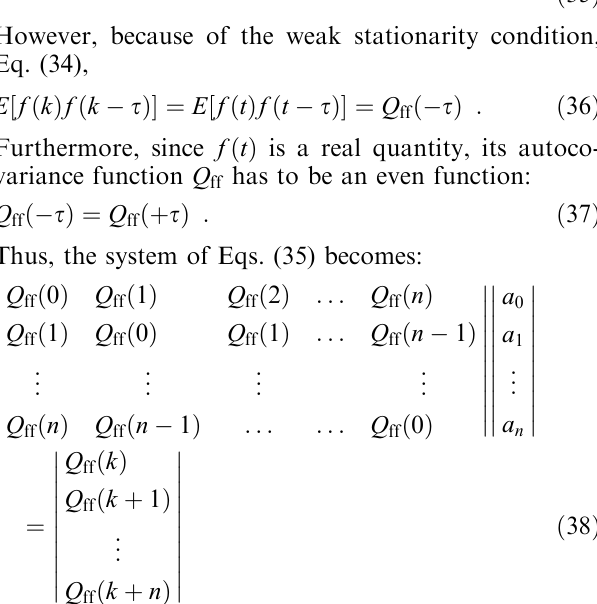
manifests itself. This is a vivid example of nonlinear systems’ ‘‘propensity to lapse into oscillations of new and has been previously detected in sunspot periodo- grams based on maximum entropy spectral